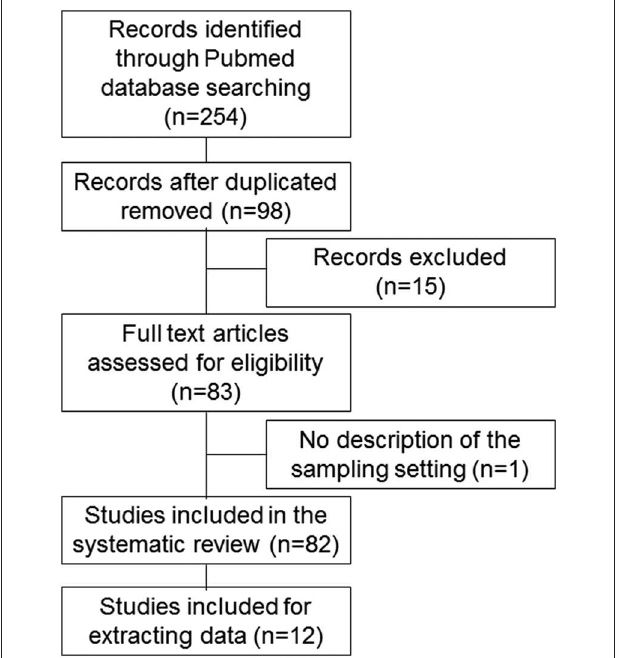
FIGURE 1 | Flow diagram of this